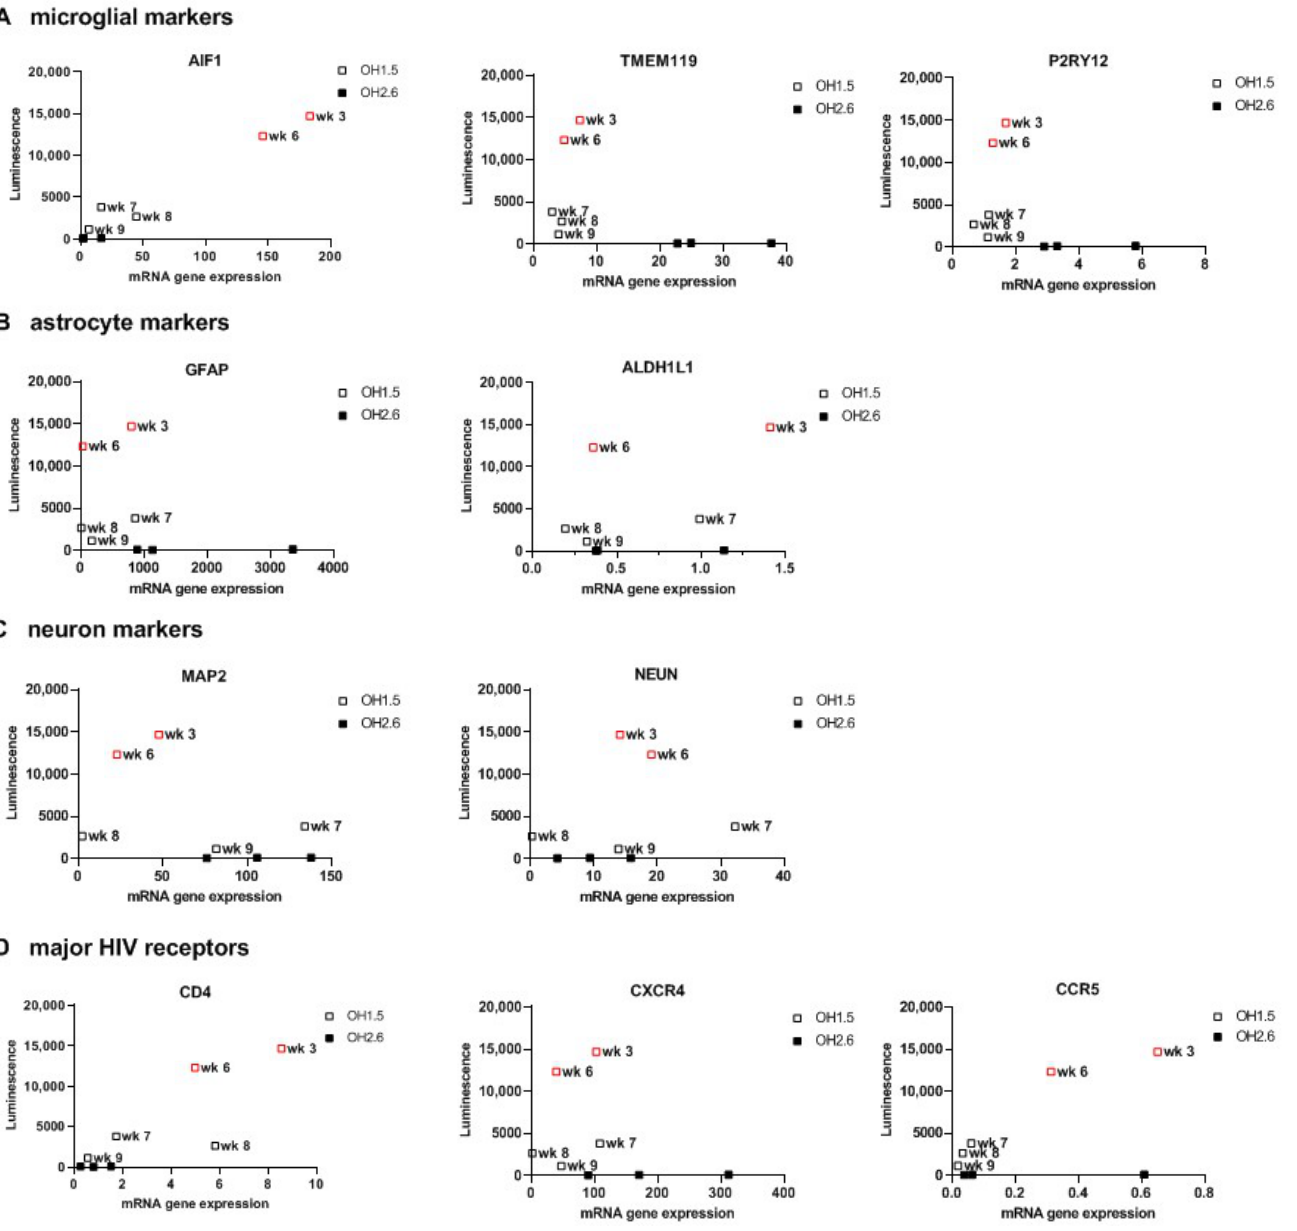
Figure 4. mRNA expression levels of microglia, astrocyte, and neuron markers and HIV receptors in 2D Organoid dissociates. ( A ) Microglia, ( B ) astrocyte, ( C ) neuron markers, and ( D ) HIV receptor expression levels were assessed by qRT-PCR and plotted against the highest luminescence value of corresponding 2D organoid dissociates. Red squares depict the organoid dissociates with the highest luminescence values. Cerebral organoids were derived from iPSC line OH1.5 or OH2.6. Gene expression was normalized to the reference gene ACTB.